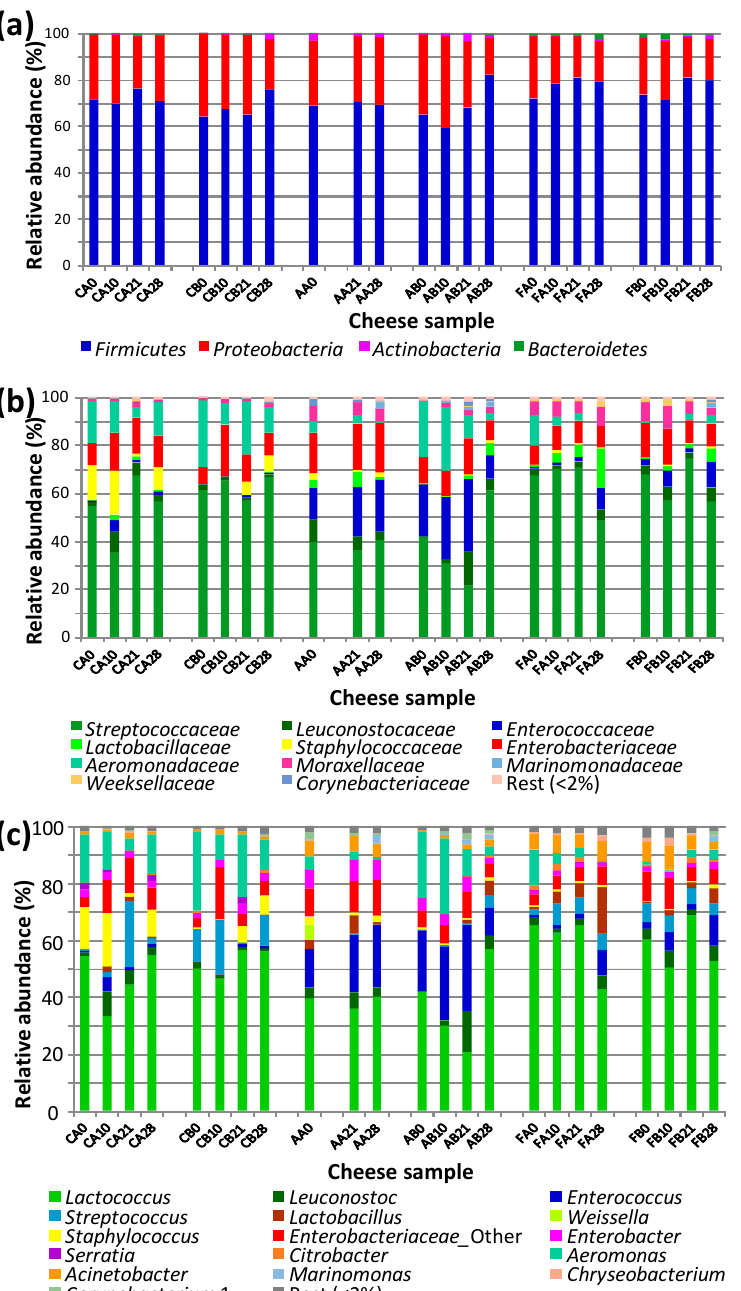
Figure 1. Bacterial diversity of Paipa cheese samples at phylum ( a ), family ( b ) and genus ( c ) levels. Cheese samples from three formal producers (C, A, F) corresponding to two independent batches (A and B) at different ripening times (0, 10, 21, 28 days) were analyzed.